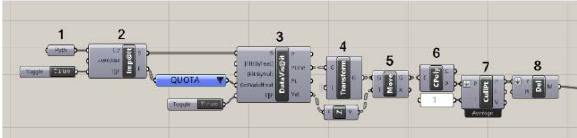
Figure 2. Instructions of the macro to process Shapefiles